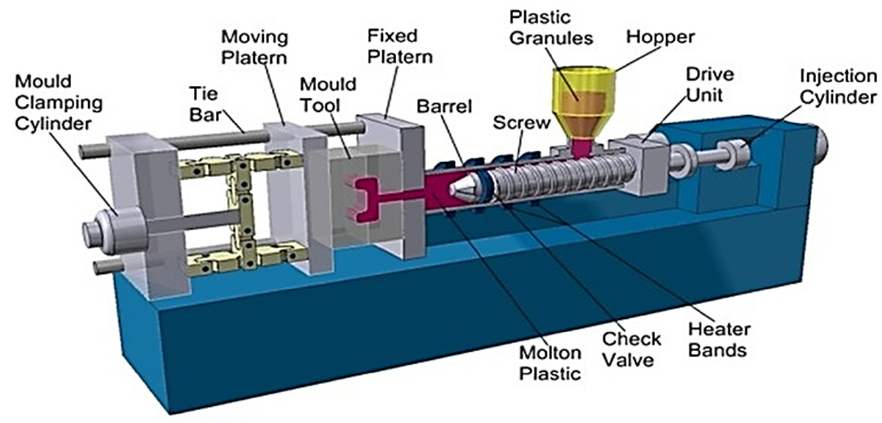
Figure 8. Schematic representation of the single screw injection molding machine.